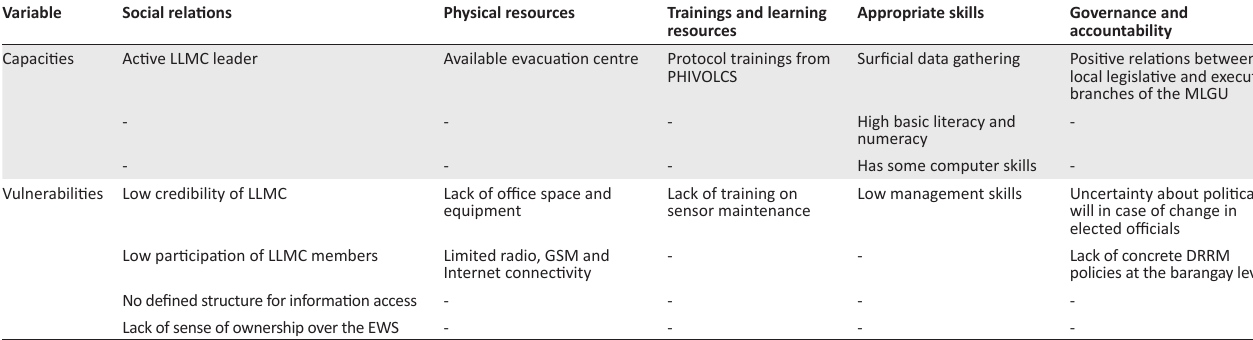
TABLE 2: Categorised capacities and vulnerabilities of site A. Variable